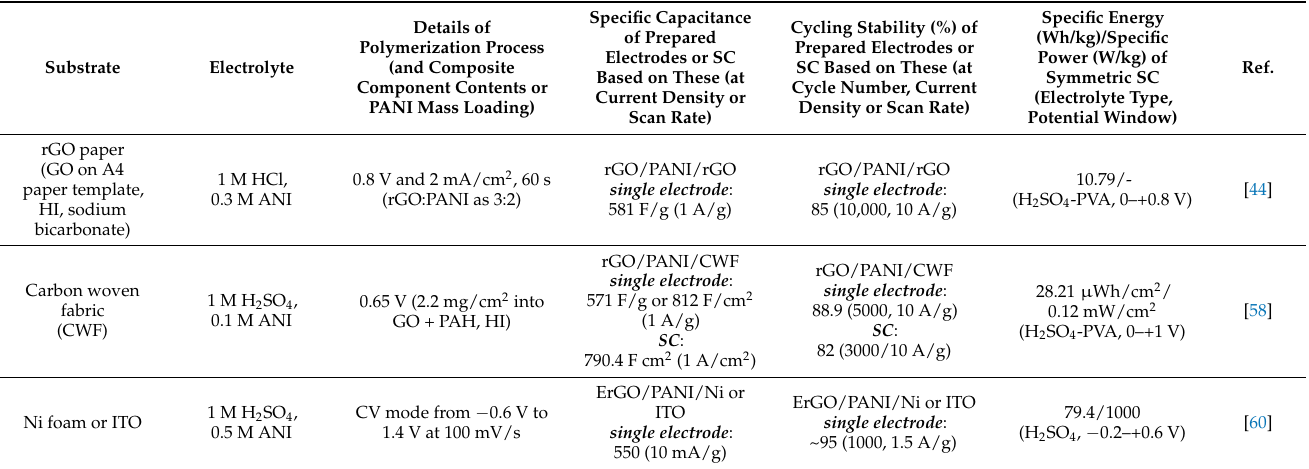
Table 2. Available data of the specific capacitance, cycling stability and summary processing details of the layered PANI/rGO single electrodes measured in three-electrode systems or full SC